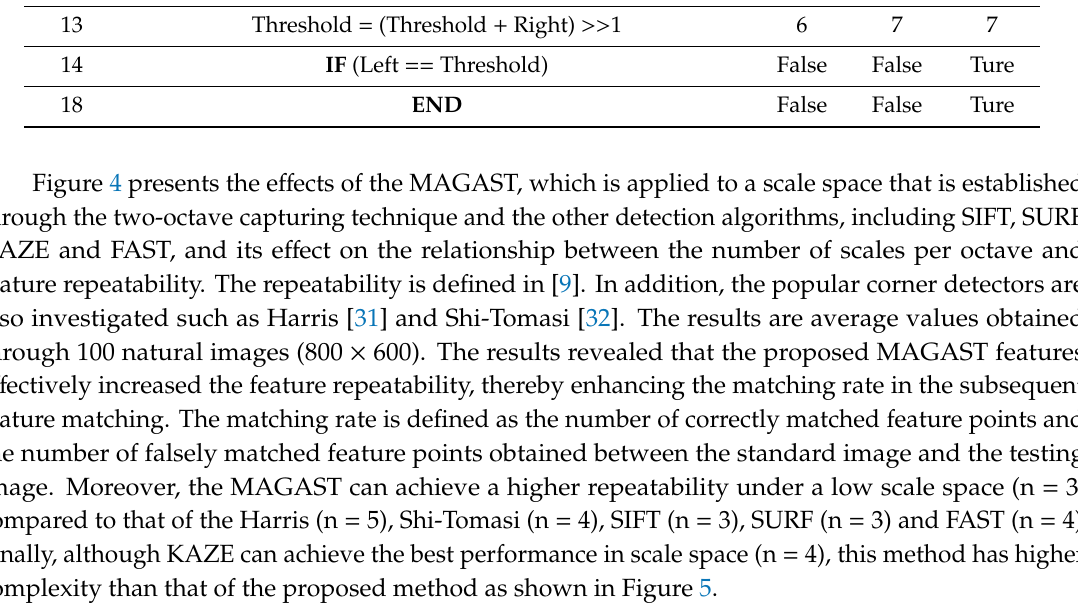
Figure 5. Performance comparison between MAGAST (proposed) and other feature detectors with relationship between the three of scales and processing time. The images are of size 800x600 and approximately 1000 keypoints are detected. 2.1.1. Lower Bound and Upper Bound Parameters The MAGAST feature detection algorithm applies the lower bound and upper bound parameters to automatically adjust the threshold value for detecting features, thereby increasing the repeatability of the features identified in a scale space. To enhance the solutions of the lower and upper bound parameters, a statistical concept is applied to solve the optimum parameters. The lower bound and upper bound parameters pertain to a mechanism for controlling the feature number range and for determining the most appropriate feature detection threshold value.